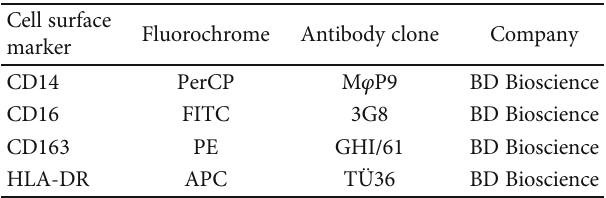
Table 2: Description of monoclonal antibodies used in the